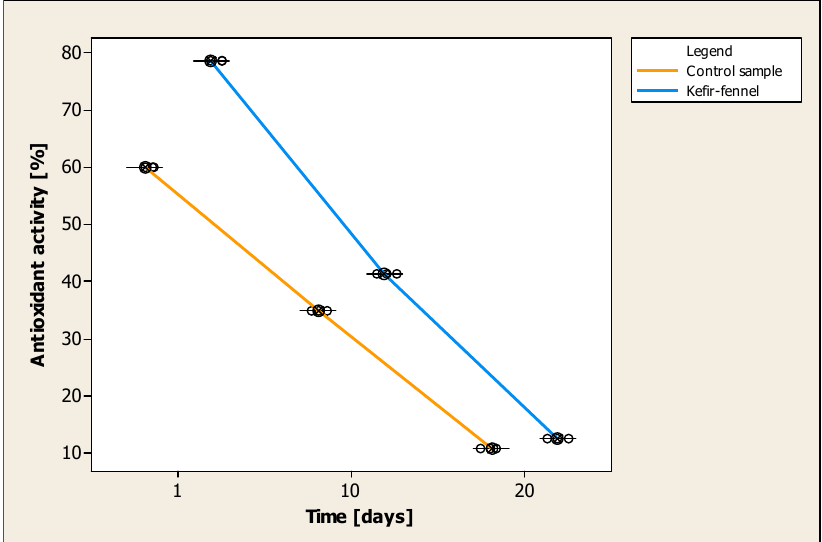
Figure 5. Comparative variation of antioxidant activity in kefir sample enriched with encapsulated fennel volatile oil and control sample.